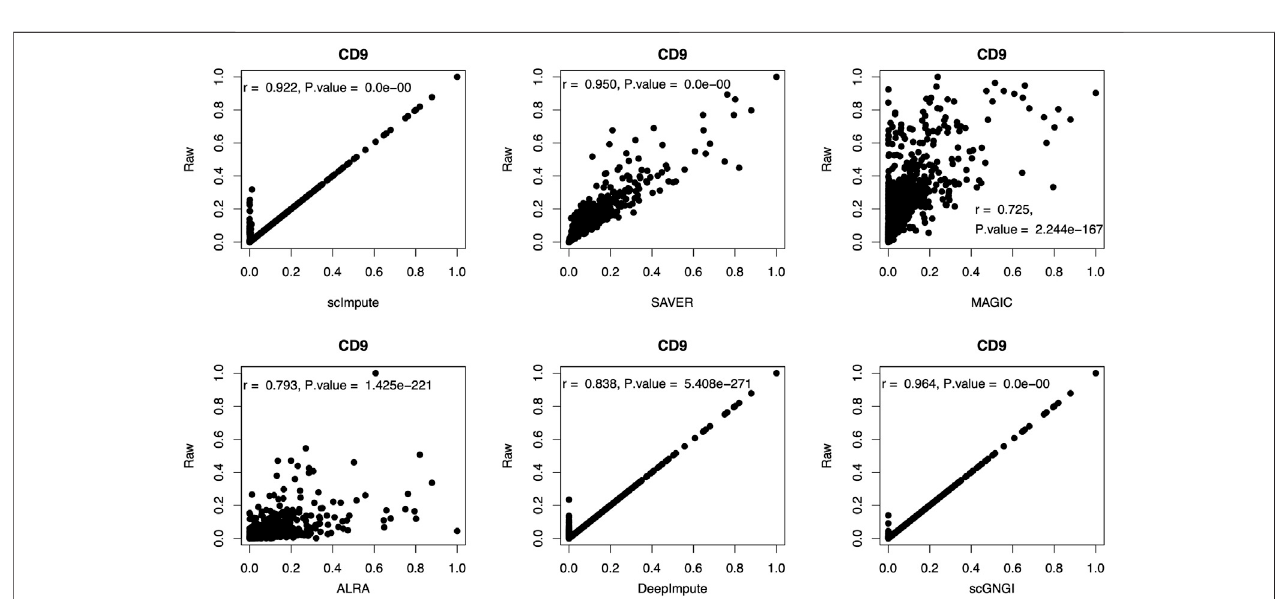
FIGURE 8 | Scatter plots ofthe expression level for the marker gene (CD9) in the raw and imputed data by using different methods. On the top, the corresponding correlation coef fi cient (r) and p value are shown for gene expression values. The two-sided correlation test is used for p values. Each dot represents a cell.